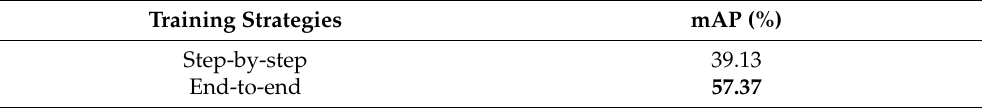
Table 3. The impact of different training strategies on detection performance. The best result is indicated by bold.